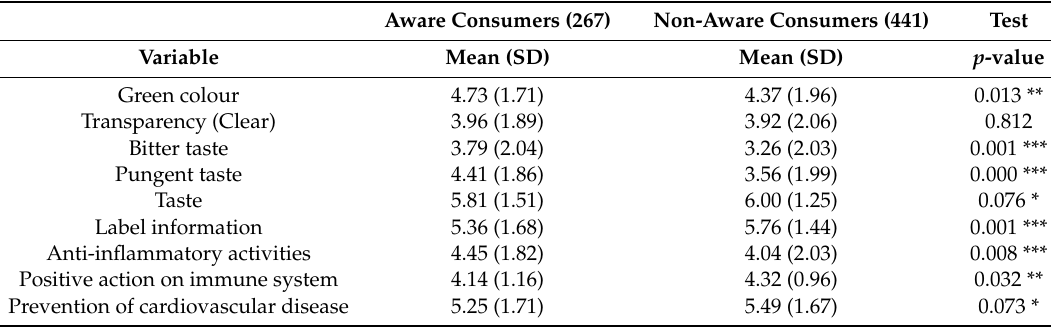
Table 4. Bivariate descriptive statistics for the intrinsic and extrinsic attributes of olive